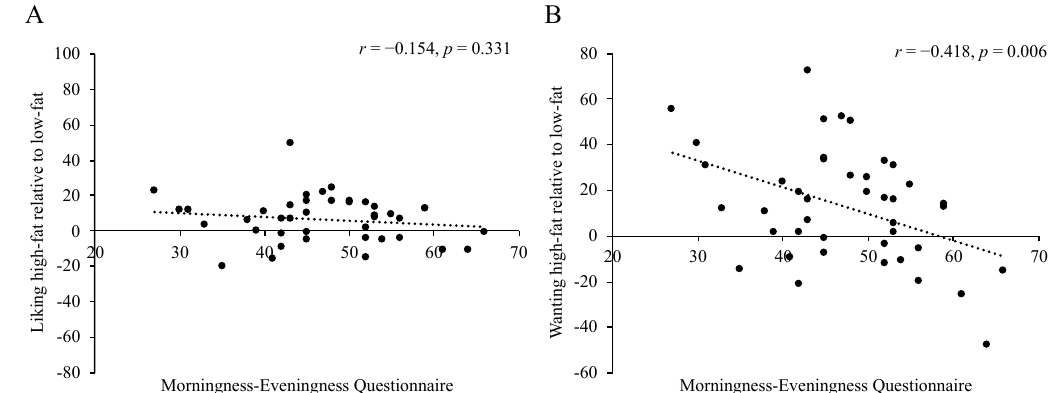
Figure 4. Relationship between scores of the Morningness–Eveningness Questionnaire and overall mean scores of liking ( A ) and wanting ( B ) for high-fat relative to low-fat food. Higher Morningness–Eveningness Questionnaire scores indicate earlier chronotypes, and positive liking / wanting scores indicate greater liking / desire for high-fat relative to low-fat. N = 42.